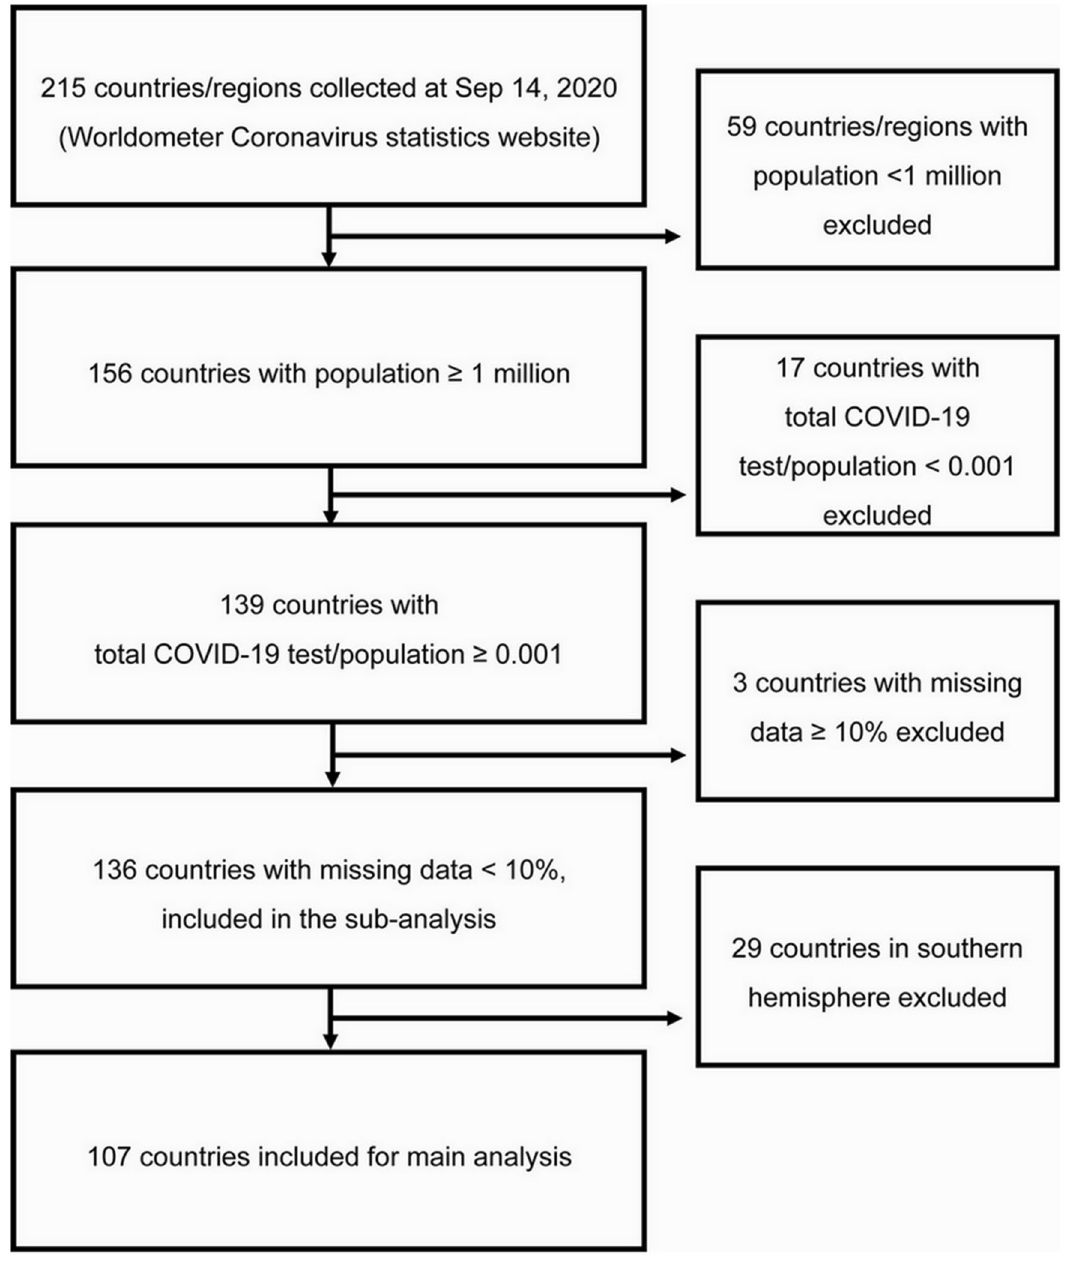
Figure 1. Flowchart of study subject selection. Data was extracted from Worldometer Coronavirus statistics website (https:// www. world omete rs. info/ coron avirus) on September 14,